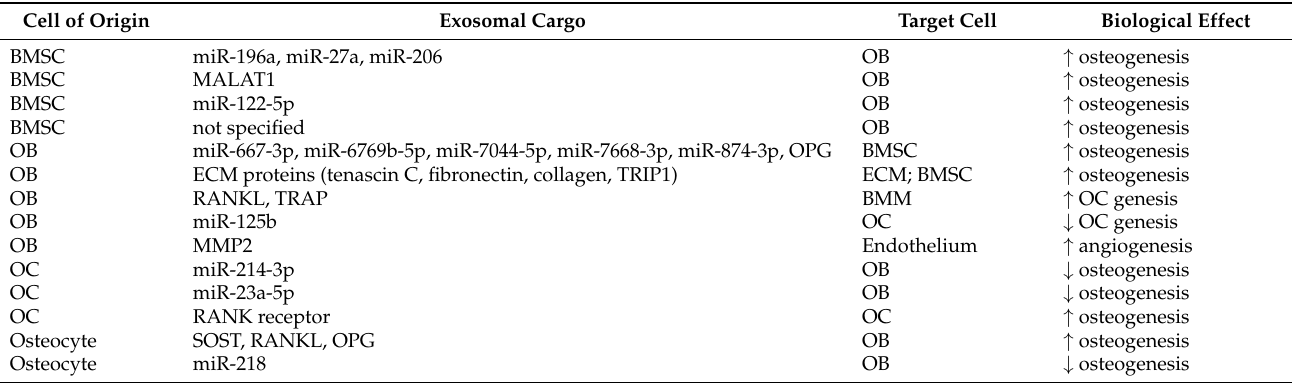
Table 5. Role of exosomes in bone remodeling. Cell of origin and target cell are specified for each exosomal molecule. BMSC, bone mesenchymal stem cell; OB, osteoblast; OC, osteoclast; BMM, bone marrow monocyte. Cell of